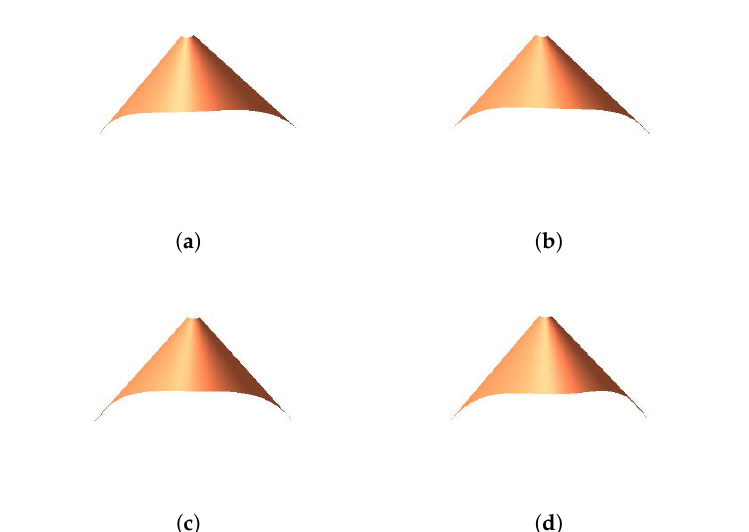
Figure 5. The effects of parameter α 2 on the 1 × 3 developable surface. ( a ) α 1 = π ( b ) α 1 = π